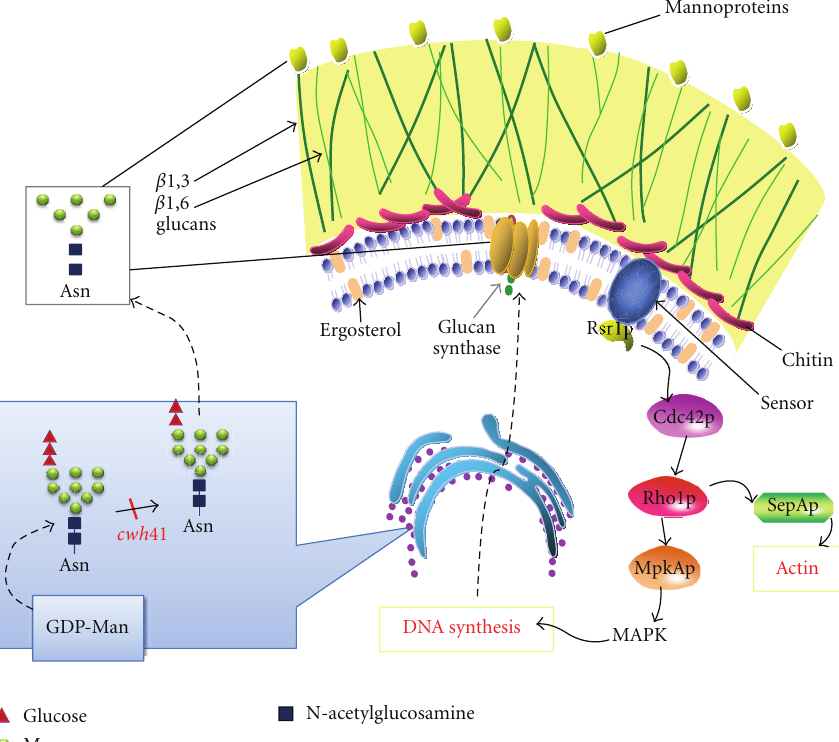
Figure 5: Proposed model of functions of N-glycosylation in A. fumigatus . Proteins that are required for cell wall synthesis or cell wall stress sensing require N-glycosylation for their proper folding, localization, and function. Disruption of N-glycosylation in A. fumigatus results in misfolding and degradation of these proteins, which thus causes cell wall defects and then leads to the activation of the Rho-type GTPases (Rsr1p/Bud1p-Cdc42p-Rho1p-) mediated CWI pathway to compensate for cell wall defects. Meanwhile activation of the CDC42 in the CWI pathway also activates SepA, an upstream component of actin rearrangement, leading to abnormalities in polarized growth.